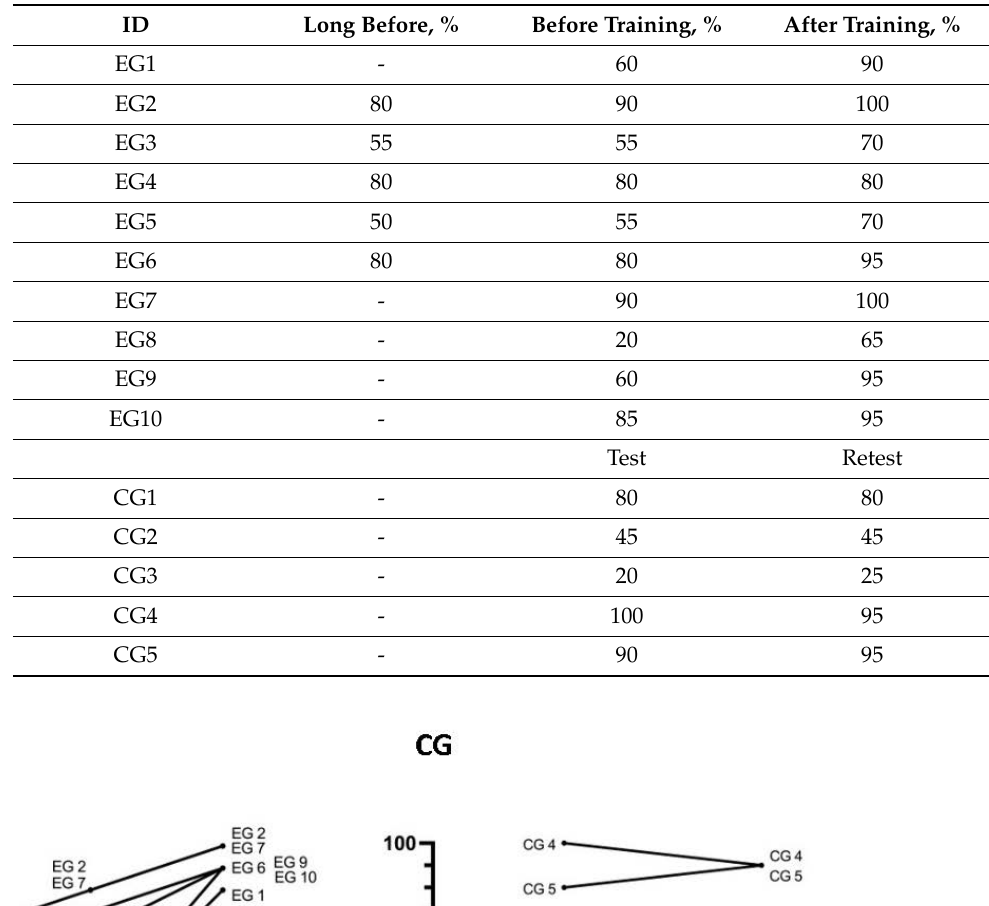
Table 3. Word recognition data.